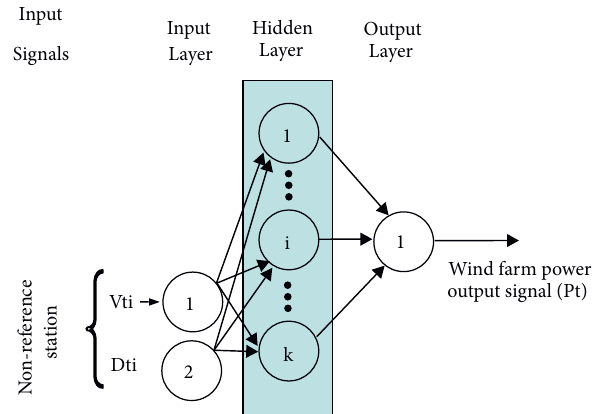
Figure 8: Schematic representation of the ANN used to generate the ADWFPC model when only using in the input layer the wind speed and direction of a WS other than the reference station of the WF.